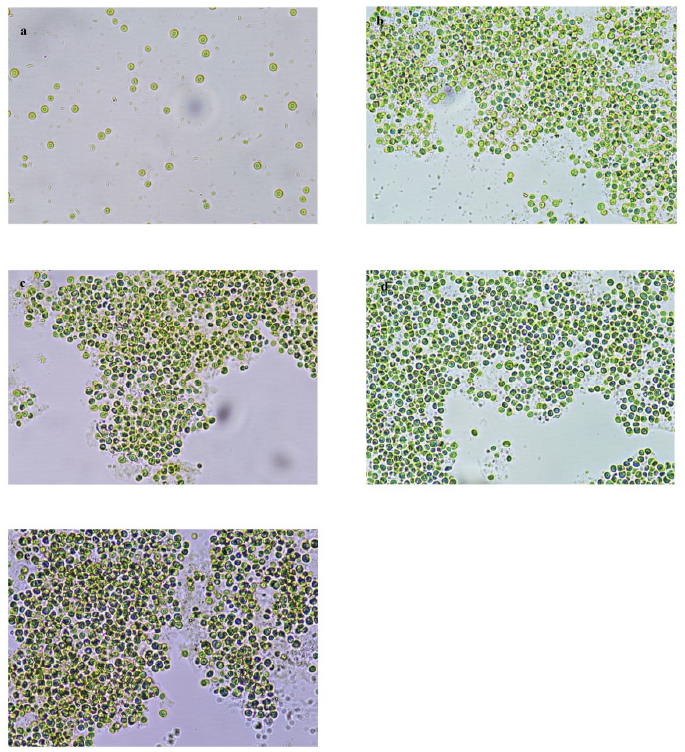
Figure 3. Microscopic images of C. vulgaris ( a ) raw ( b ) Al 2 (SO 4 ) 3 , ( c ) AlCl 3 , ( d ) Fe 2 (SO 4 ) 3 , and ( e ) FeCl 3 flocculated at a magnification of 40×.